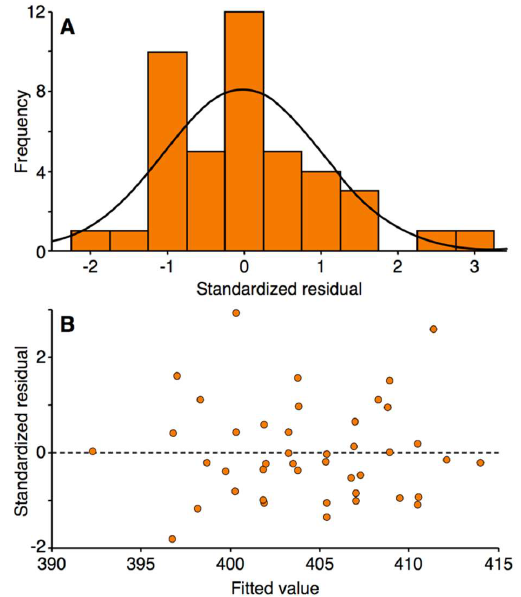
Figure 2. Frequency distribution graph of the standardized residuals ( A ) and a scatter plot of the standardized residuals versus the fitted values ( B ).